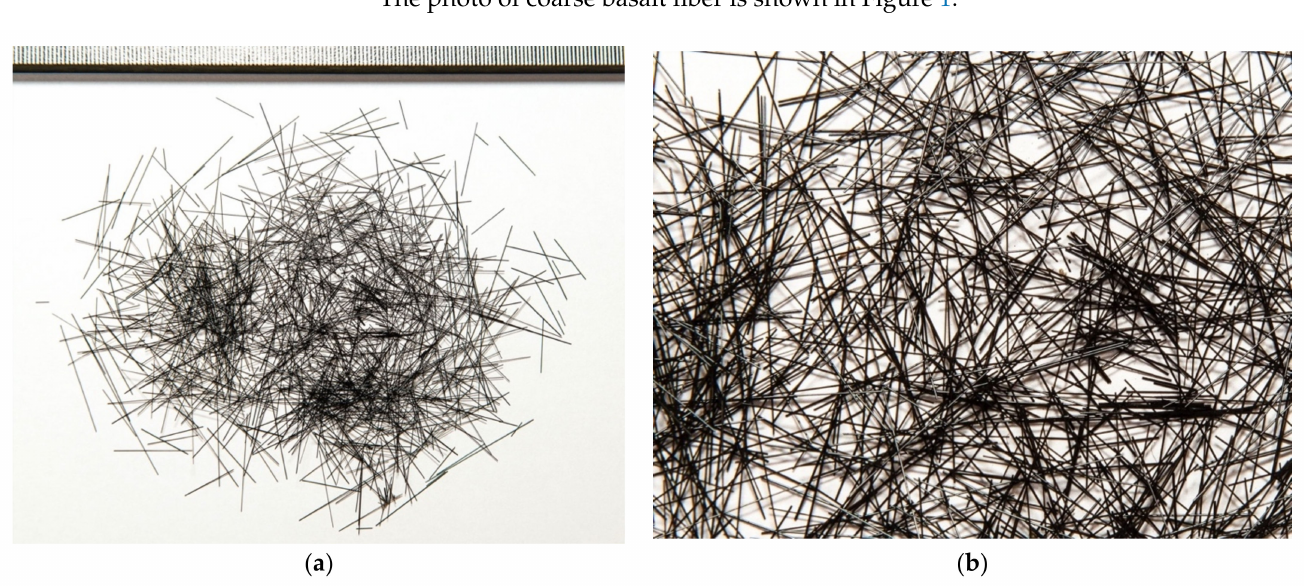
Figure 1. Coarse basalt fiber: ( a ) Normal view; ( b ) Increased